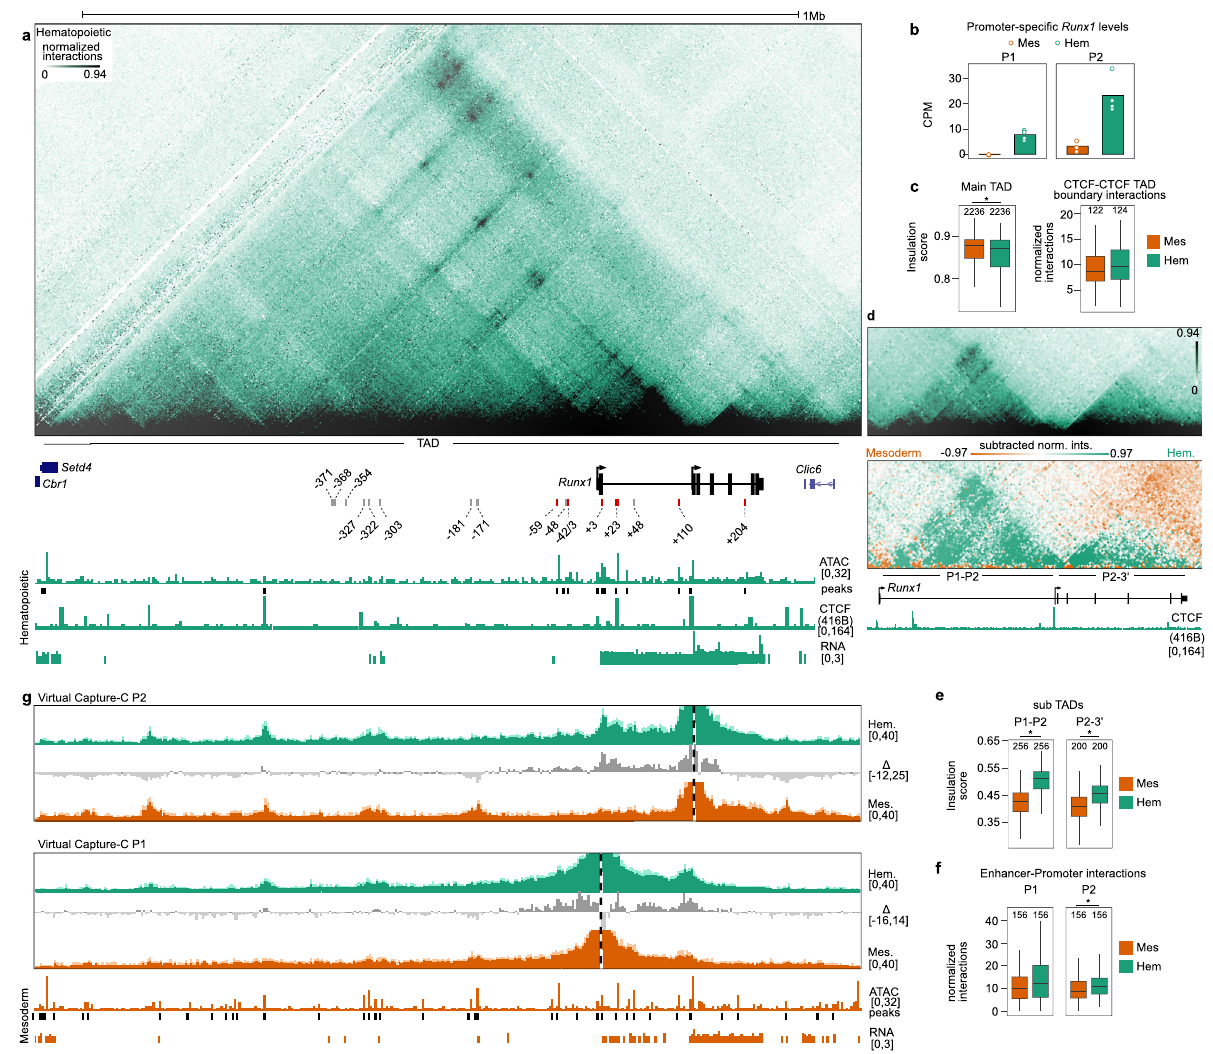
Fig. 3 EHT progression is associated with sub-TAD reinforcement, increased Runx1 expression and P1 activation. a Tiled-C matrix from HPCs (2 kb resolution, threshold at the 94th percentile, n = 4). Runx1 promoters and location of Runx1 TAD are labeled below the matrix. RPKM-normalized ATAC-seq track is shown with called peaks (MACS2 adjusted p < 0.05, peaks called from one merged bam fi le). CPM-normalized poly(A)-minus RNA-seq ( n = 4) is shown. CTCF occupancy in 416B hematopoietic progenitor cells is shown. Previously published enhancer regions are indicated. Enhancer regions that are accessible in HPCs are shown as red bars and numbered according to their distance from the Runx1 start codon in exon 1. Enhancers that did not overlap ATAC-seq peaks are identi fi ed by gray bars. b Promoter-speci fi c Runx1 levels in mesoderm and HPCs. Data were analyzed from three biologically independent experiments. c Left, insulation score (intra-TAD interaction ratio) of the main Runx1 TAD (*, Kruskal – Wallis and Dunn ’ s test, two-sided adjusted p = 2.1 × 10 − 7 ). Right, quanti fi cation of interactions between the four outermost CTCF peaks at the edges of the TAD. d Top, zoom of Tiled-C data at 2 kb resolution with a threshold at 94th percentile. Below, subtraction of normalized Tiled-C matrices between mesoderm and HPCs. The matrix is a subtraction of the signal between two merged matrices ( n = 4, 2 kb resolution, threshold at + 97th and − 97th percentile). e Insulation scores (intra-TAD interaction ratio) of the two Runx1 sub-TADs (*, Kruskal – Wallis and Dunn ’ s test, P1-P2 TAD two-sided adjusted p = 3.1 × 10 − 43 and P2-3 ′ TAD two-sided adjusted p = 6.6 × 10 − 13 ). f Quanti fi cation of total interactions from the viewpoint of each promoter with all previously published enhancers (Supplementary Table 2) (*, Kruskal – Wallis and Dunn ’ s test, two-sided adjusted p = 0.004). g Virtual Capture-C pro fi les (obtained from Tiled-C data, see “ Methods ” ) from the viewpoint of both Runx1 promoters in mesoderm (orange tracks) and HPCs (green tracks). Runx1 promoters (P1 and P2) are indicated by a vertical dashed line. Dark colors represent the mean reporter counts in 2 kb bins ( n = 4) normalized to the total cis -interactions in each sample. Standard deviation is shown in the lighter color. Subtractions of the signal between two cell types as indicated are shown as gray tracks. ATAC-seq and peaks and RNA-seq from mesoderm are indicated in orange below Capture-C tracks. c , e , f Boxplot centre shows median, bounds of the box indicate 25th and 75th percentiles, and maxima and minima show the largest point above or below 1.5 * interquartile range. Outlying points are not shown. Data were analyzed from the total number of bins indicated above each boxplot from four biologically independent